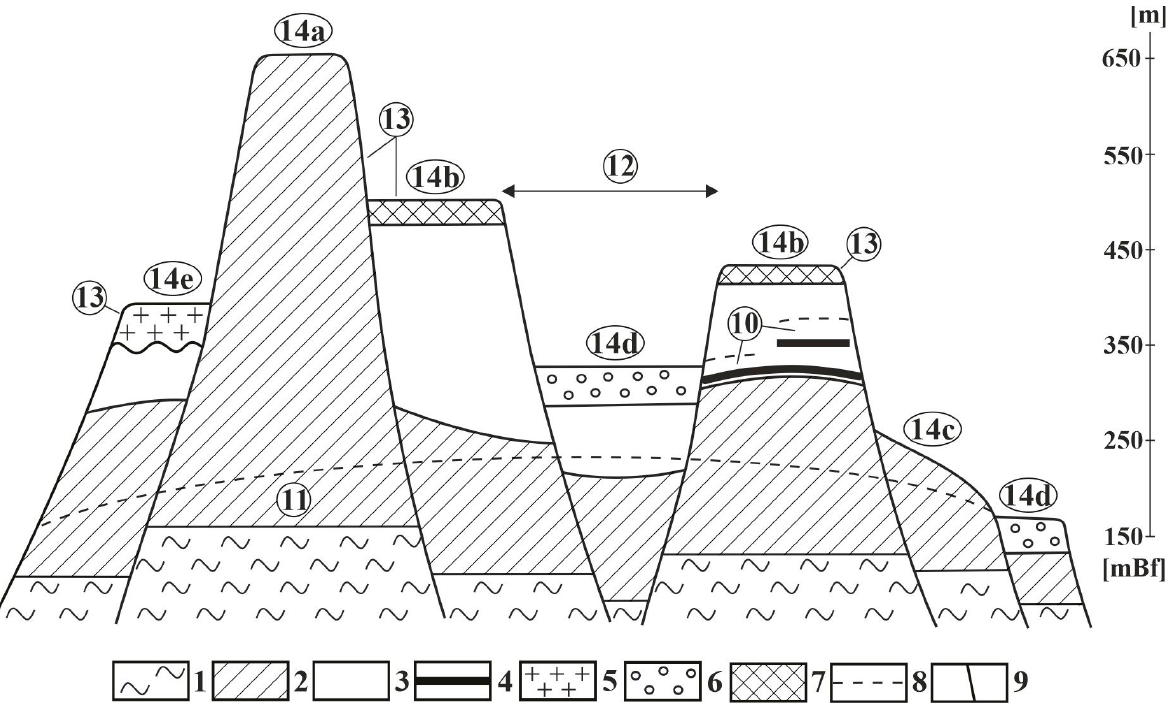
Figure 4. Block types of the mountains [31] (modified) based on [9,10]. 1. Non-karstic rock, 2. Triassic carbonates, 3. Jurassic, Cretaceous and Eocene limestone, 4. Impermeable intercalation, clay, marly limestone, silica, etc. 5. Basalt, 6. Gravel, 7. Loess, 8. Karst water table, 9. Fault, 10. Perched water table, 11. Main karst water, 12. Basin, graben, 13. Mount, 14a. Horst in summit position, 14b. Horst elevated to summit position, 14c. Threshold surface, 14d. Cryptopeneplain, 14e. Block covered with basalt.